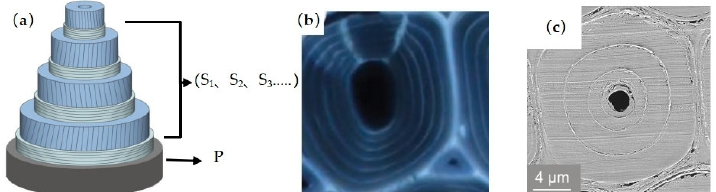
Figure 5. ( a ) Schematic diagram of tension wood fiber wall with multiple layers consisting of alter- nating broad and narrow layers; ( b ) Laetia procera tension wood fiber structure [46]; ( c ) Phyllostachys pubescens fiber structure. P: primary wall; S: secondary wall.